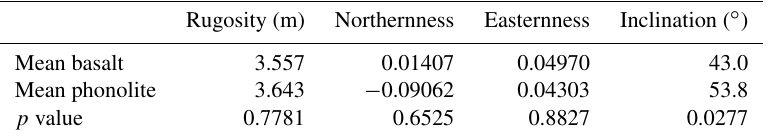
Table A5. Environmental plot characteristics. Inclination on phonolites was (despite efforts to sample similar environments) significantly higher than on basalt. Components of exposition (northernness and easternness) and rugosity showed no significant differences (unpaired Whitney test).